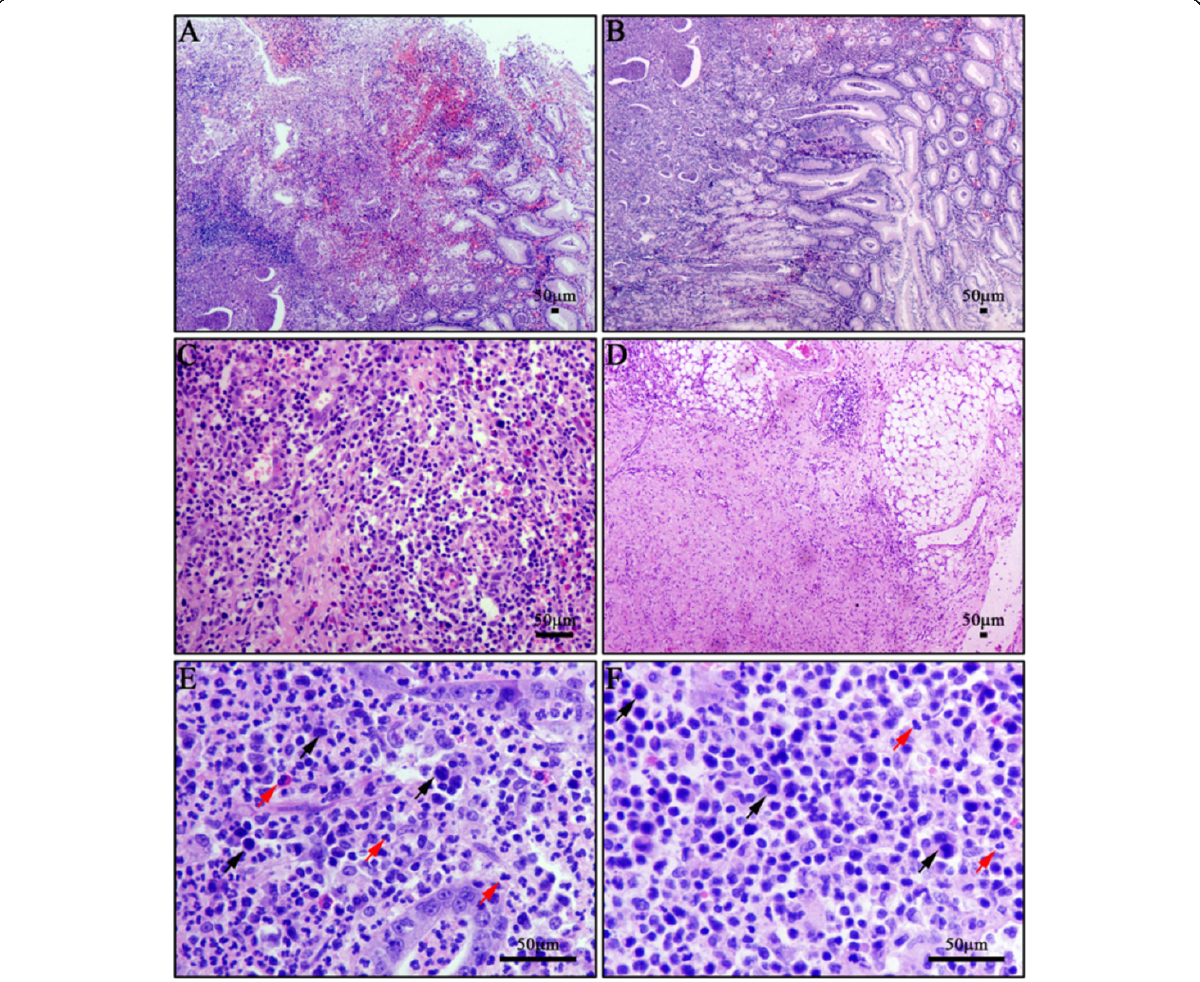
Figure 1 Histological features of this case. A : The tumor formed an ulcerating mucosal mass. B : Intraepithelial lymphocytosis was also seen in the adjacent gastric mucosa. C and D : The ulcer was deep and caused the transmural infiltration by florid mixed inflammatory cells. E and F : Neoplastic lymphoid cells (black arrow) were scattered amidst the inflammatory infiltrate. A large number of neutrophils and eosinophils were also observed (red